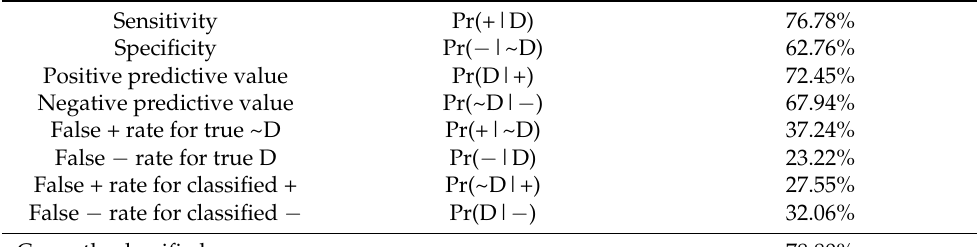
Table 5. The classification statistics and classification table.